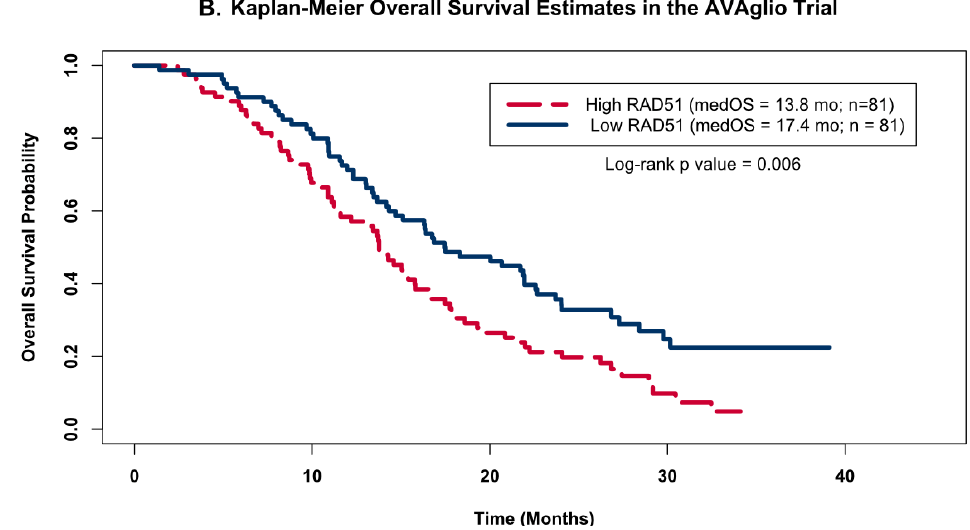
Figure 4. Kaplan–Meier OS Models. Kaplan–Meier OS probability estimates comparing GBM patients grouped by RAD51 expression levels. High expression (red) levels were defined as values above the cohort’s median log2-transformed expression level, while low (blue) was defined as below the median expression. ( A ) shows the KM curves for the patients from this study (high Rad 51 = 12, low Rad51 = 12); ( B ) shows external validation using the same analysis for the publicly available independent dataset obtained as part of the AVAglio trial (high Rad 51 = 81, low Rad51 = 81).